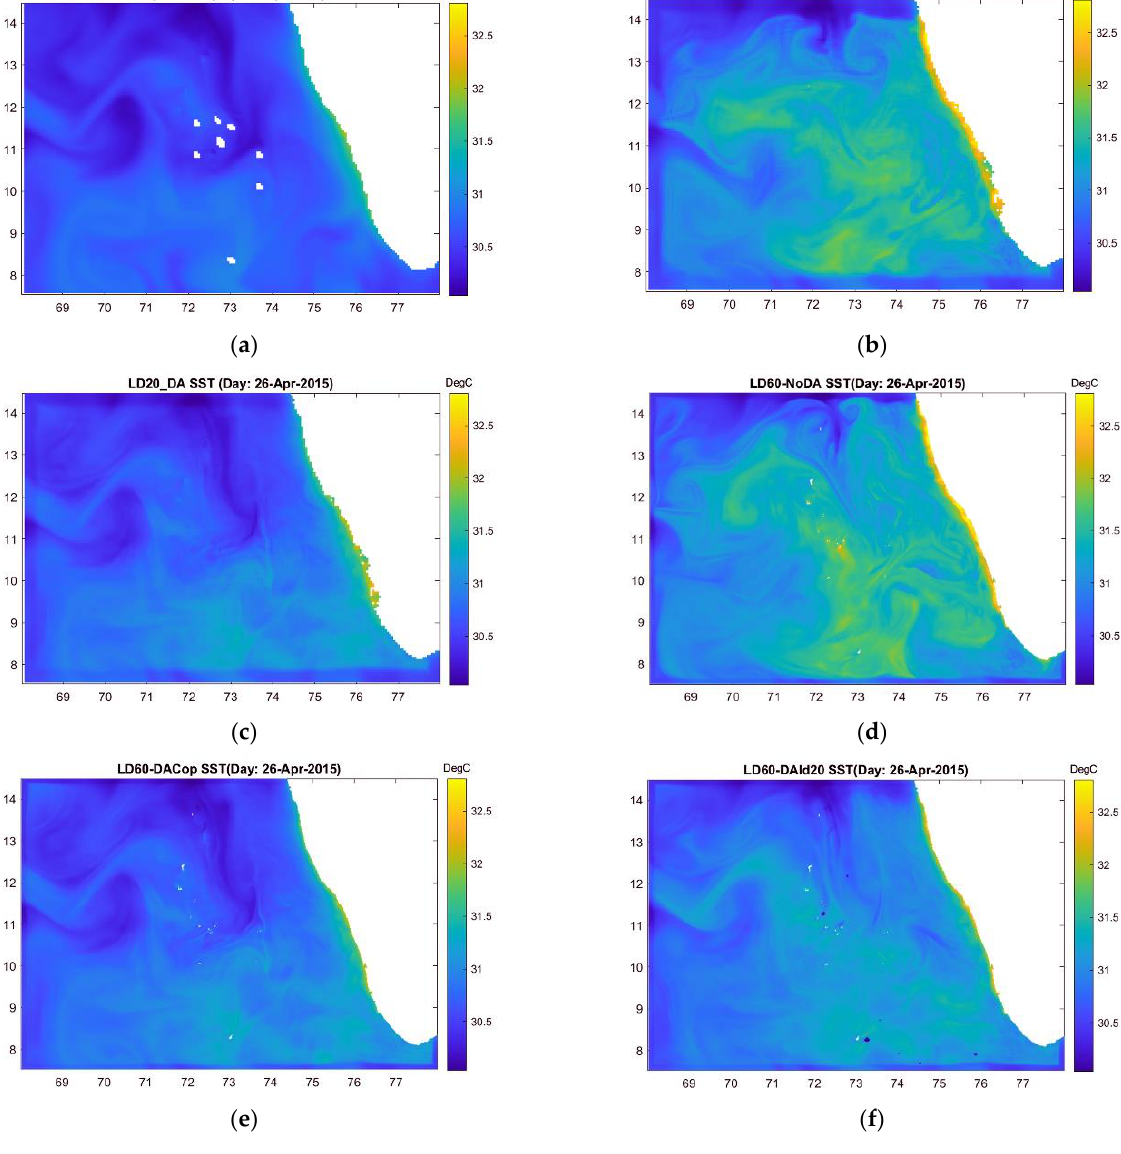
Figure 19. Daily averaged SST for 26/04/2015 from ( a ) the operational data-assimilating global model at 1/120 resolution, generated using EU Copernicus Marine Service Information [38], ( b ) nested model LD20 at 1/20 0 without NDA, ( c ) nested model LD20 at 1/20 0 with NDA using 3D temperature, salinity, and velocities data from the global model, ( d ) nested model LD60 at 1/60 0 without NDA, ( e ) nested model LD60 at 1/60 0 with NDA using 3D temperature, salinity, and velocities data from the global model, ( f ) nested model LD60 at 1/60 0 with NDA using 3D temperature, salinity, and velocities data from the nested LD20